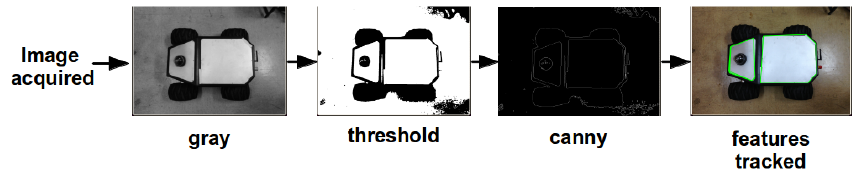
Figure 3. Features extraction procedure example for a ground